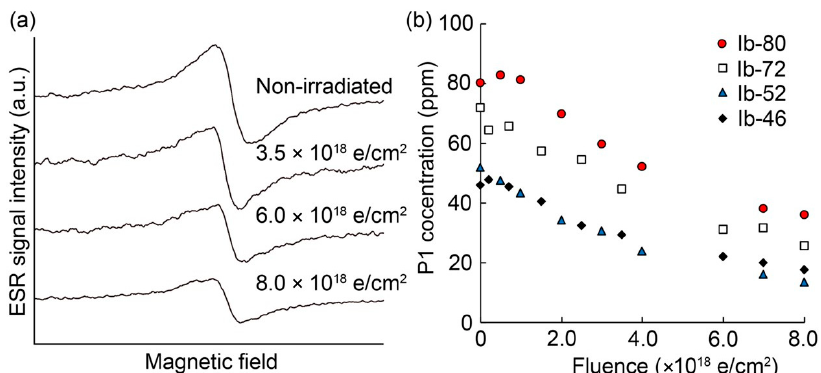
Figure 2. Irradiation fluence dependence of P1 center concentrations ([P1]) in type-Ib diamonds after irradiation and subsequent annealing. ( a ) ESR spectra of P1 center for Ib-46 at the irradiation fluence of 0.0, 3.5, 6.0, 8.0 × 10 18 e/cm 2 . ([100]//B 0 ) ( b ) Irradiation fluence dependence of [P1] for Ib-80 (closed red circles), Ib-72 (open black circles), Ib-52 (closed blue circles), Ib-46 (closed black circles), respectively.